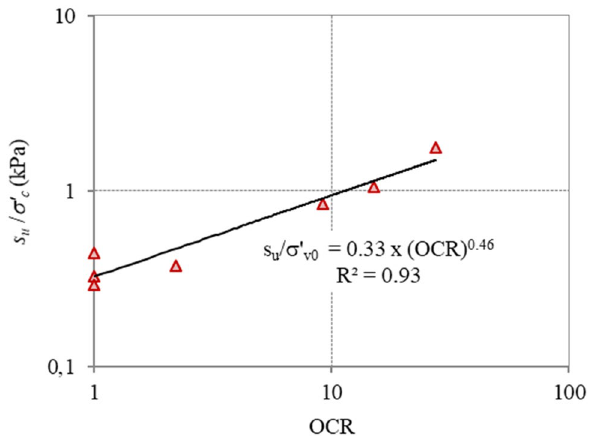
Fig. 10 Normalized undrained shear strength as a function of OCR